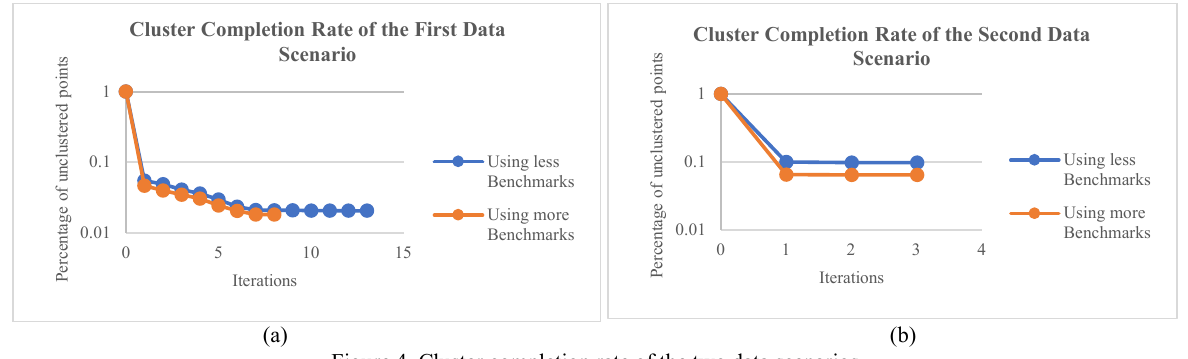
Figure 4. Cluster completion rate of the two data